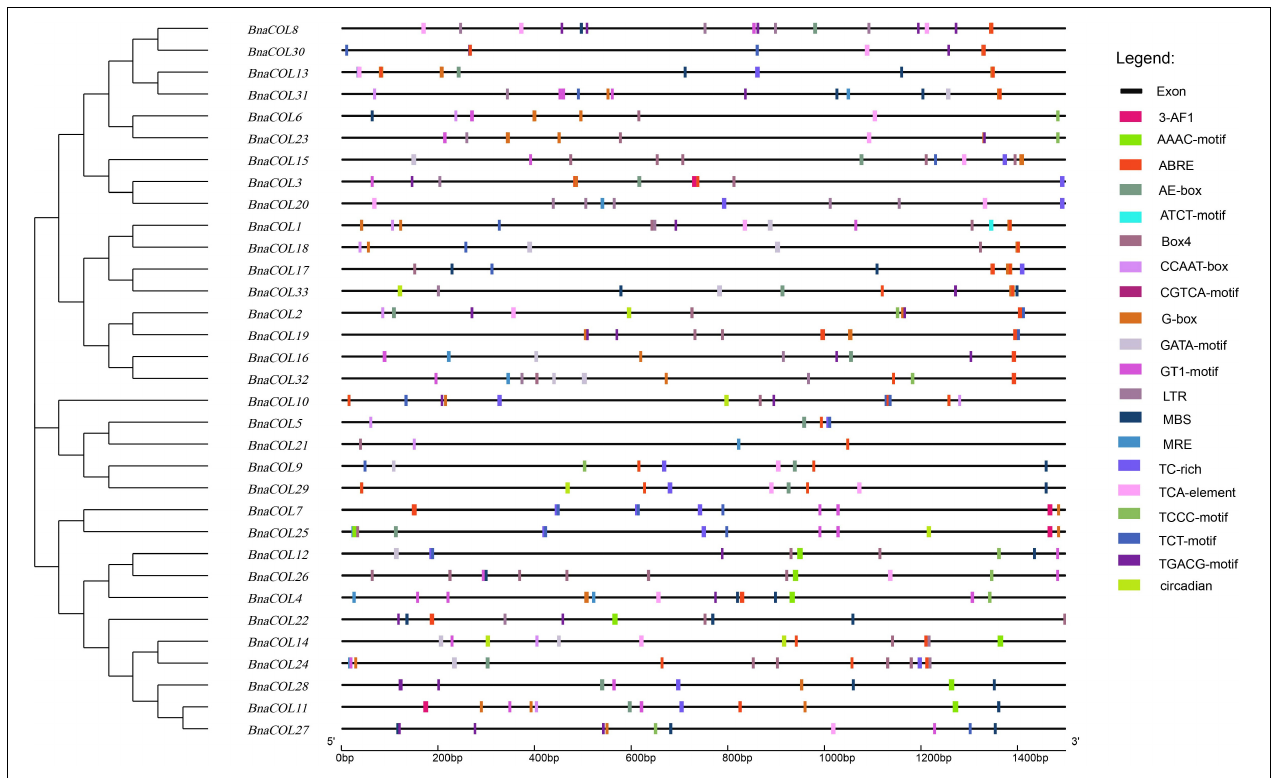
FIGURE 6 | Cis- acting element analysis of COL gene family in B. napus. The boxes with different colors on the black line represent different cis elements.